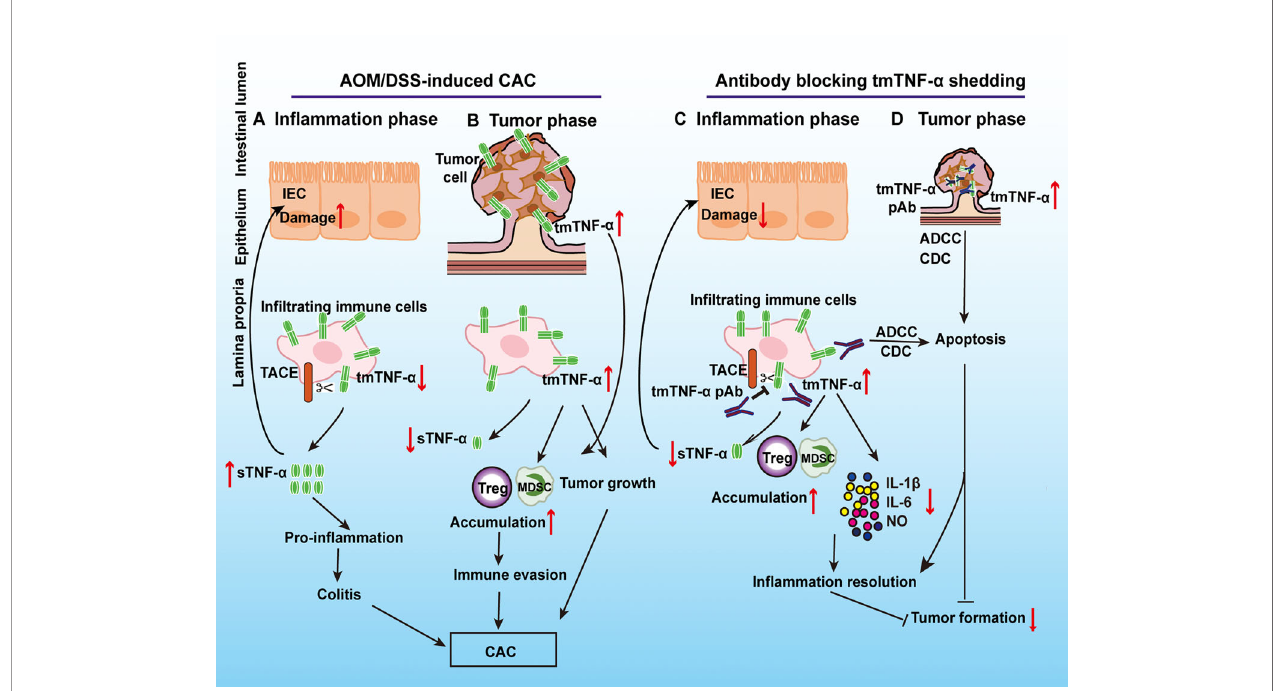
FIGURE 9 | Schematic summary of the protective effect of tmTNF- a on CAC by a speci fi c antibody that prevents tmTNF- a shedding. In AOM/DSS-induced CAC, tmTNF- a is rapidly processed into sTNF- a that is mainly released by in fl ammatory cells in the in fl ammation phase to promote colitis (A) , while tmTNF- a expression is increased on epithelial cells in addition to in fi ltrated leukocytes in malignant transformation to facilitate CAC development. Increased tmTNF- a expression promotes the accumulation of MDSCs and Treg cells, which leads to immune evasion (B) . Using a speci fi c antibody to prevent tmTNF- a shedding and increase tmTNF- a expression in the in fl ammation phase inhibits the production of in fl ammatory mediators (IL-1 b , IL-6, and NO) and the in fi ltration of M1 macrophages, induces apoptosis of in fl ammatory cells, and promotes intracolonic accumulation of MDSCs and Treg cells (C) . As a result, in fl ammation resolution is facilitated and subsequent tumor formation is suppressed. In addition, the antibody induces apoptosis of tmTNF- a -positive tumor cells by ADCC and CDC (D)